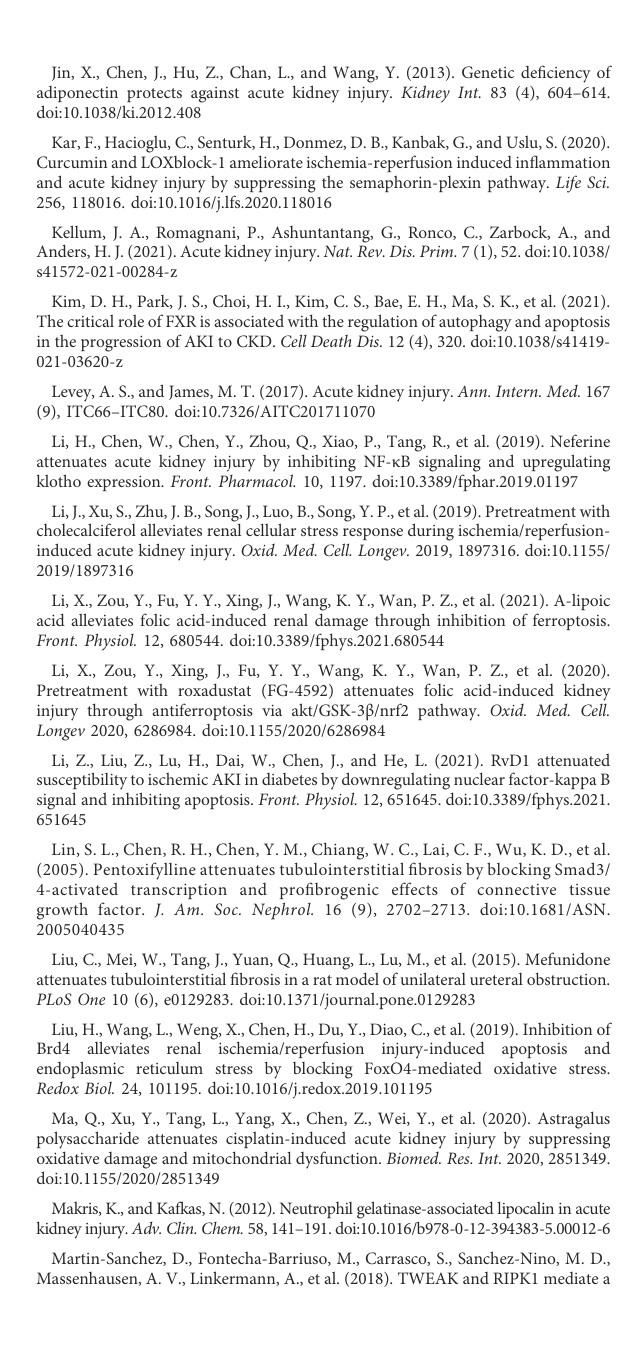
mefunidone on HK-2 cells viability. HK-2 cells were treated with mefunidone at concentrations of 0, 20, 40, 80, 120 and 160 µg/ml. * p < 0.05, ** p <